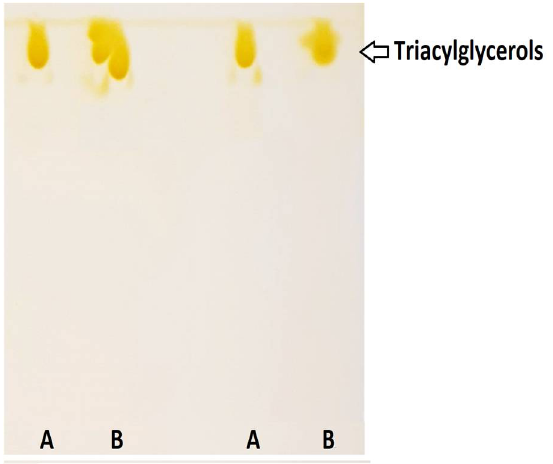
Figure 1. Thin-layer chromatography separation: ( A ) purified DRCSO and ( B ) non-purified DRCSO.